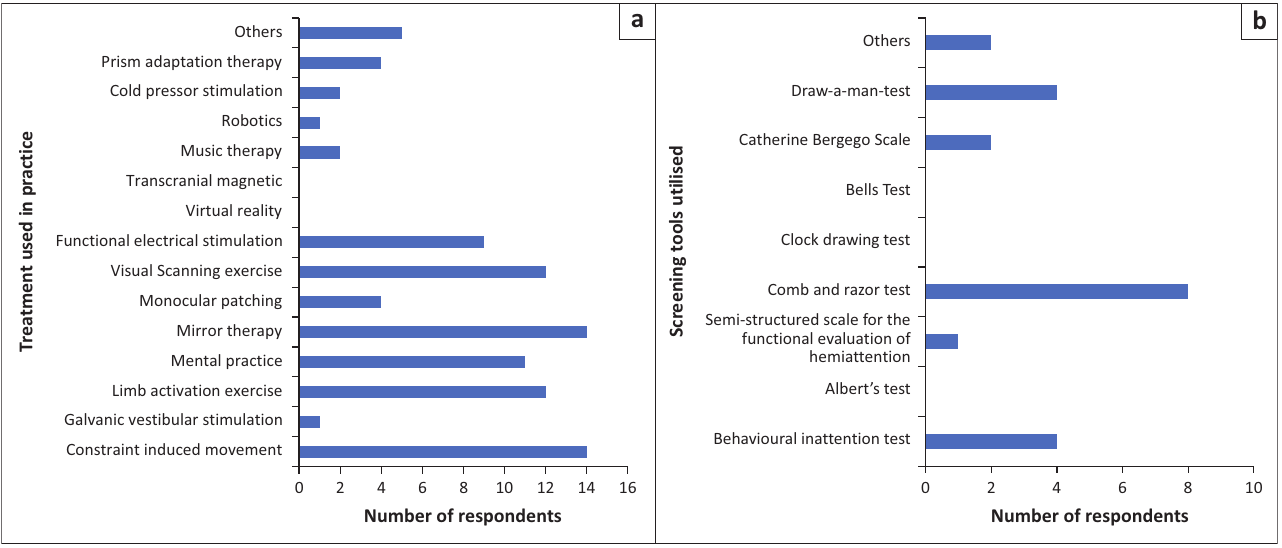
FIGURE 1: (a and b) Treatment and screening tools utilised by physiotherapists in practice. Physiotherapists’ perceived barriers and enablers to the treatment of post- stroke unilateral spatial neglect.